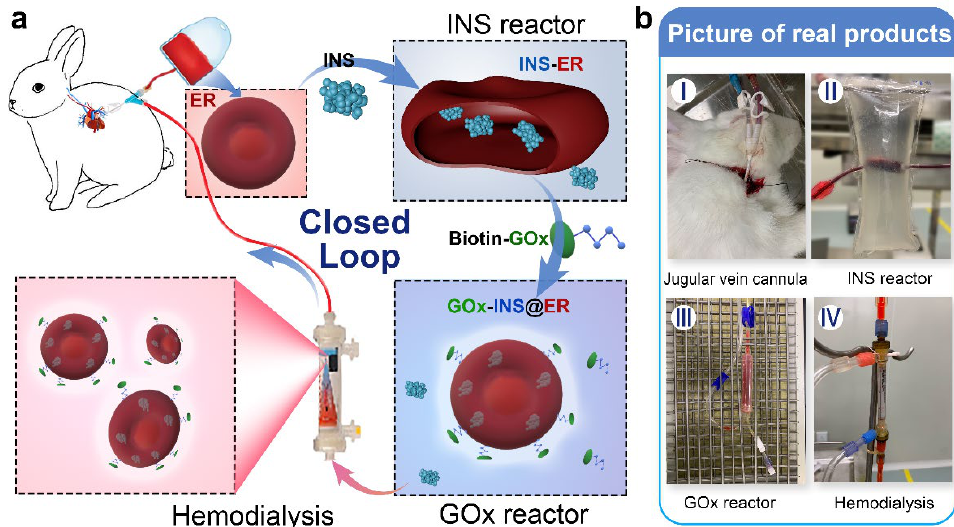
Scheme 1. Schematic representation of the in vitro, closed-loop autologous ER-mediated delivery (CAER) platform. ( a ) The schematic representation shows the CAER platform, accomplished by the construction of a glucose-responsive, self-regulated INS release system (GOx-INS@ERs). First, blood was drained via a jugular vein cannula and eventually put back into the animal’s vein. INS was loaded into ERs in the INS reactor by the hypotonic dialysis method. Second, GOx was modified on the surface of the INS@ERs in the GOx reactor. Finally, GOx-INS@ER solution was dialyzed to remove residual drugs before being returned to the venous blood. ( b ) Pictures of actual products, including the jugular vein cannula, INS reactor, GOx reactor, and hemodialysis equipment.